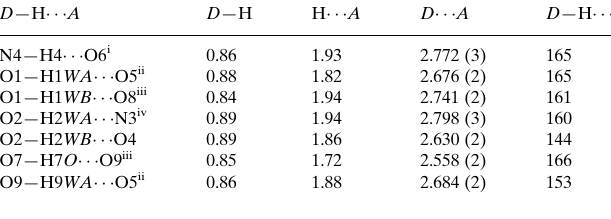
Hydrogen-bond geometry (A˚ , (cid:4)